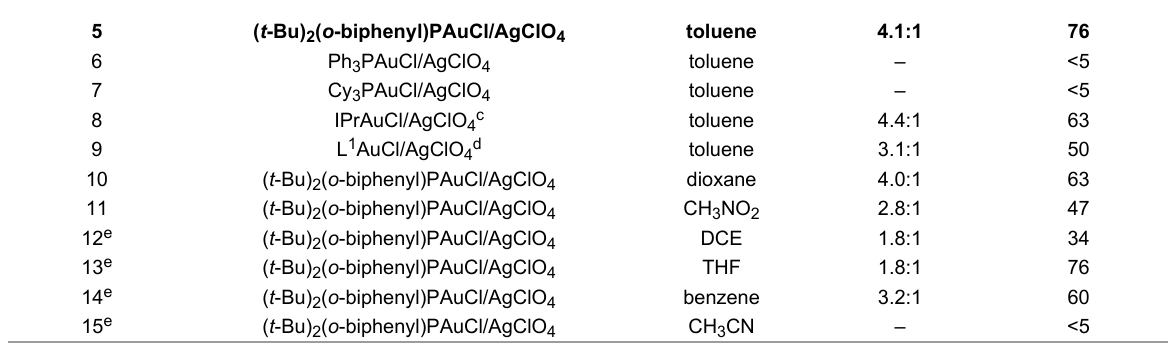
Table 2: Screening catalysts and solvents. (continued) 5